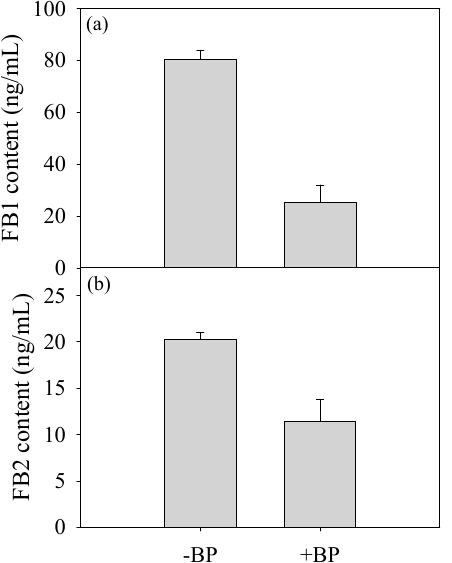
Figure 3. Concentration of the mycotoxin contents. ( a ) Fumonisin B1 (FB1); ( b ) fumonisin B2 (FB2) in response to banana peel, determined in triplicate.